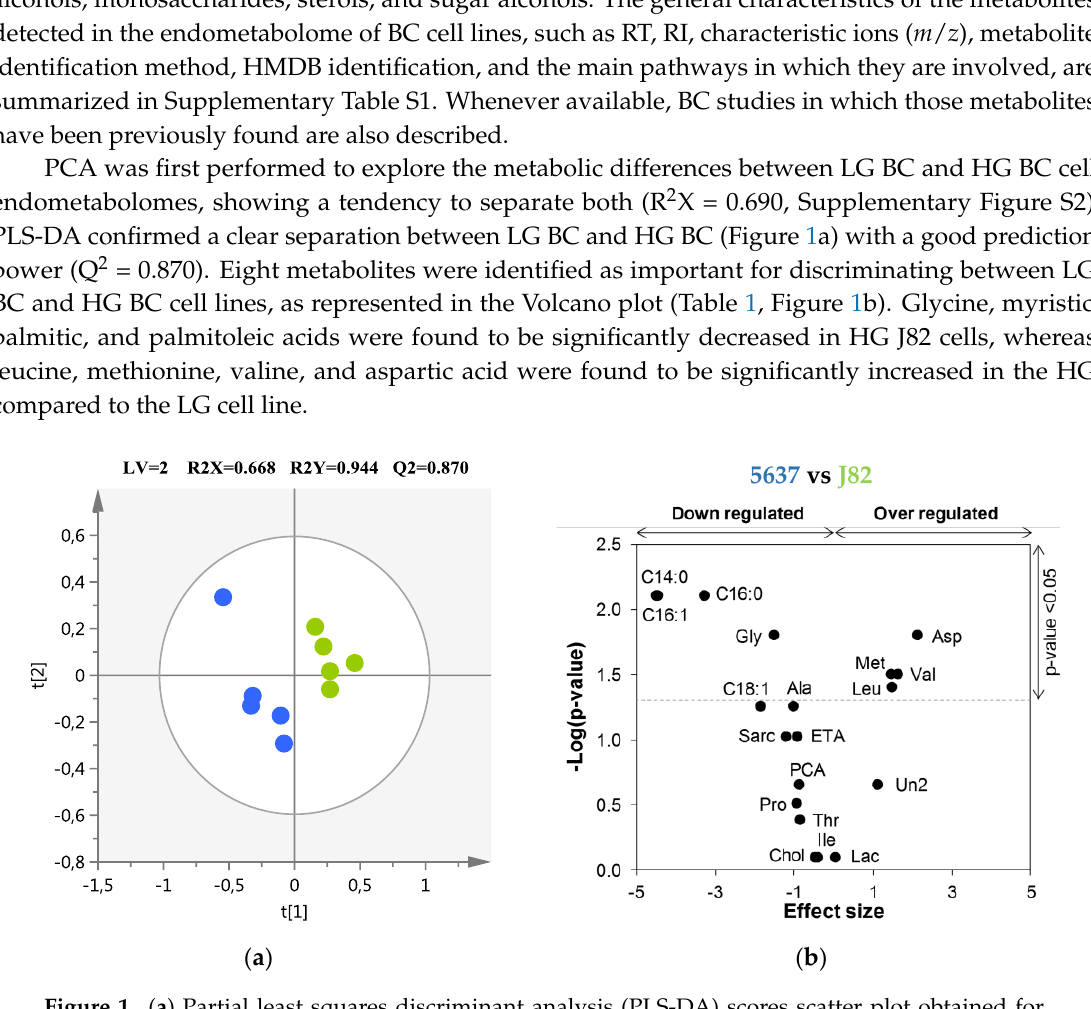
Figure 1. ( a ) Partial least squares discriminant analysis (PLS-DA) scores scatter plot obtained for the cancer cell lines 5637 ( n = 5, low-grade, ●) and J82 ( n = 5, high-grade, ●). The ellipses indicate the 95% confidence limit of the model; ( b ) Volcano plot showing the metabolites contributing to the discrimination between high-grade (HG) J82 and low-grade (LG) 5637 cells. Horizontal dashed line indicates the significance level ( p < 0.05). Three-letter codes are used for amino acids. C14:0, myristic acid; C16:0, palmitic acid; C16:1, palmitoleic acid; Chol, cholesterol; ETA, ethanolamine; Lac, lactic acid; PCA, pyroglutamic acid; Sarc, sarcosine; Un2, unknown 2. Table 1. List of metabolites selected as important for the discrimination between HG (J82) and LG (5637) bladder cancer cells. Values for ES, ES SE , p , and AUC are indicated for each metabolite. Metabolite